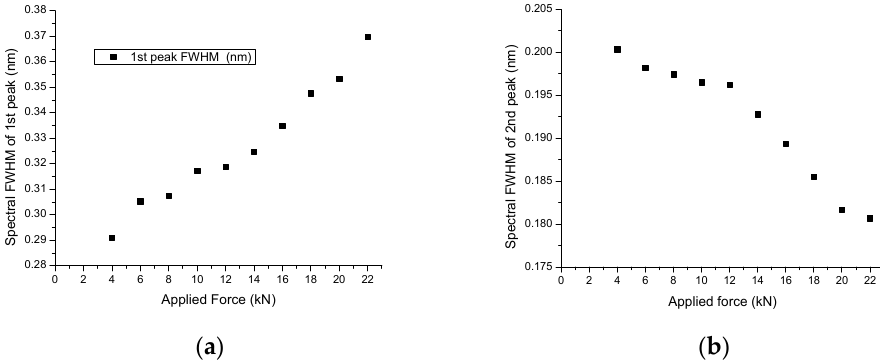
Figure 7. ( a ) Spectral FWHM of primary peak and ( b ) Spectral FWHM of the secondary peak, with applied force on the coupon.